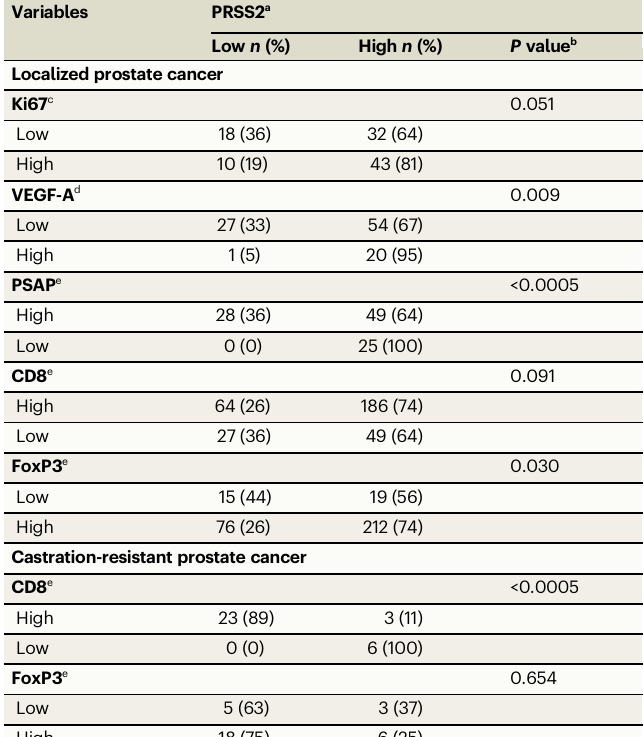
Table 2 | Associations between PRSS2 expression and selec- ted biomarkers in localized prostatic carcinomas and castration-resistant prostate cancer Variables